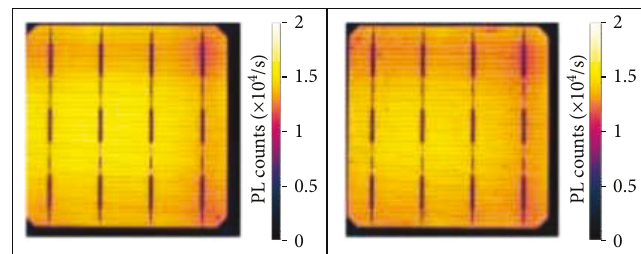
Figure 1: Photoluminescence images of two normal production solar cells (group 1) showing relatively uniform PL counts across the cell and only small reductions in the PL response in localised regions.